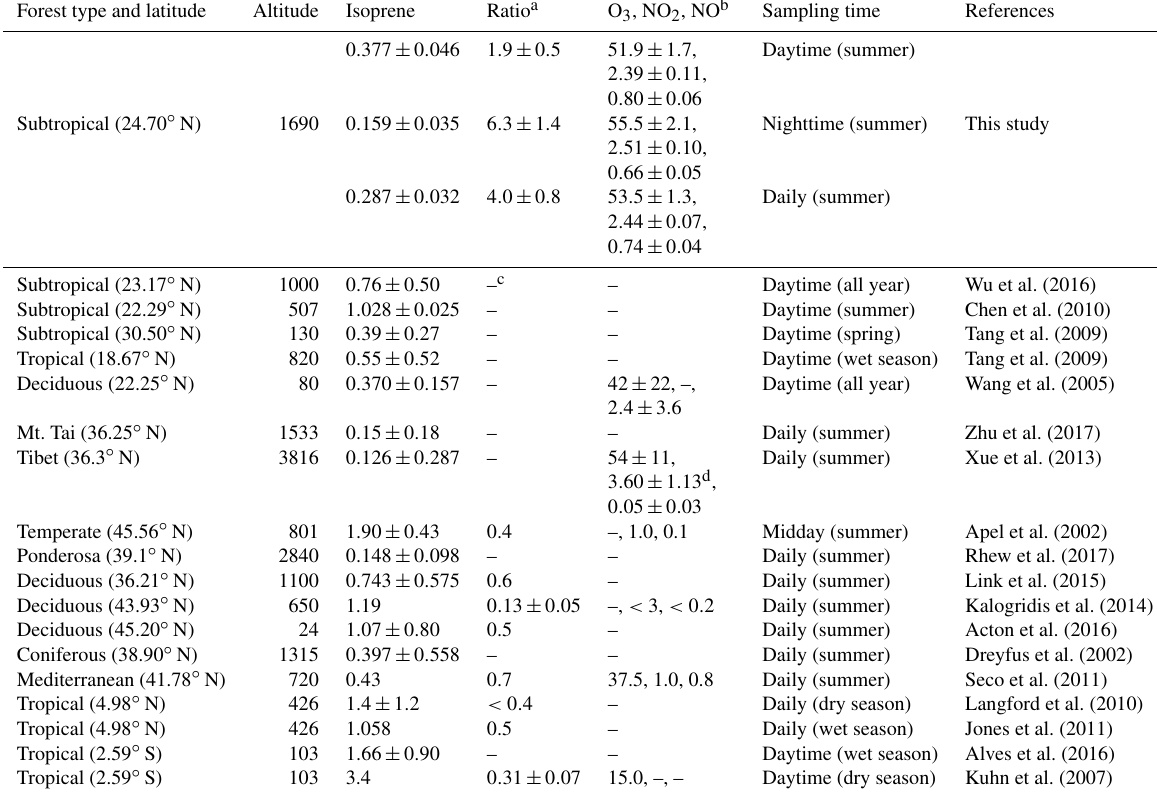
Table 1. Comparison of average concentrations (in ppbv, mean ± 1 σ standard deviation or 95% confidence interval) of isoprene, O 3 , NO 2 and NO measured at the Nanling site, as well as (MVK + MACR) / isoprene ratios (ppbv / ppbv) and altitude (ma.s.l.), with other forest or mountaintop sites.